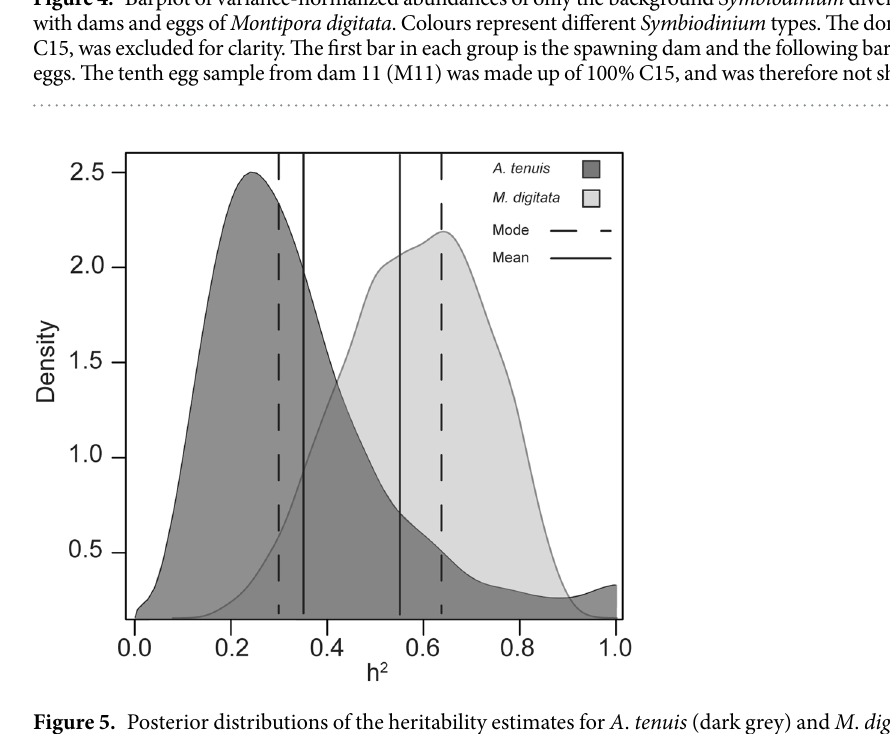
work is needed to document Symbiodinium diversity in juveniles of broadcast spawning corals, as well as to elu- cidate molecular mechanisms regulating the establishment of this symbiosis.